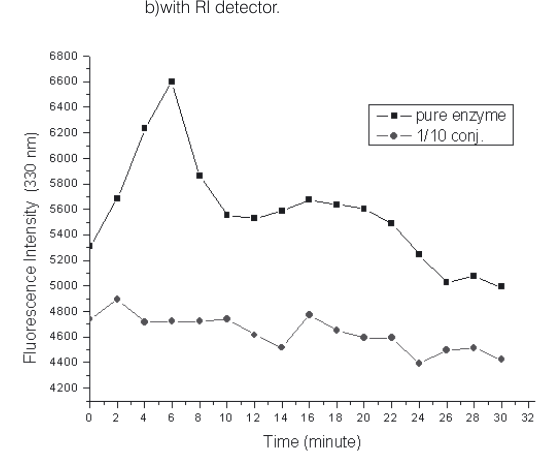
Figure 2. Fluorescence intensities of conjugate (n purified HRP depending on time (Ex. 297 nm, Em. 330 nm) at 60°C, pH 7.